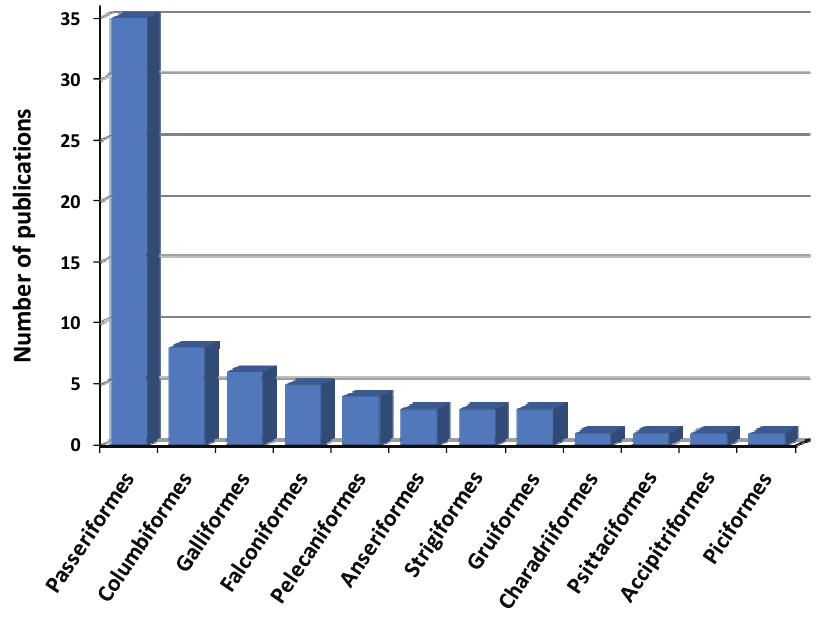
Figure 2. Number of publications involving WNV experimental inoculations in wild birds, distributed by taxonomic